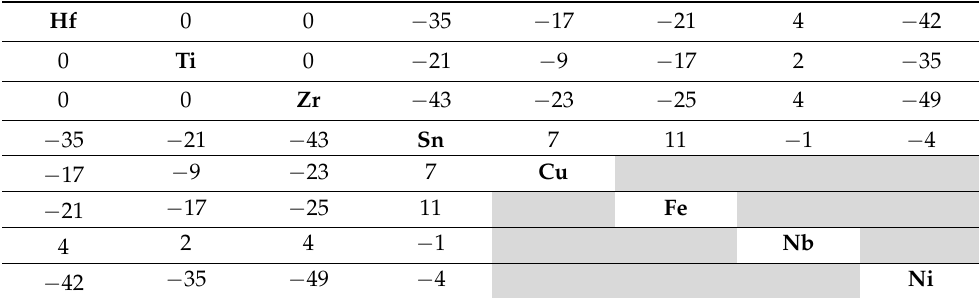
Table 2. Binary mixing enthalpies (in kJ · mol − 1 ) for unlike atom pairs constituting the HfTiZrSn M ( M = Cu, Fe, Nb, Ni) alloys